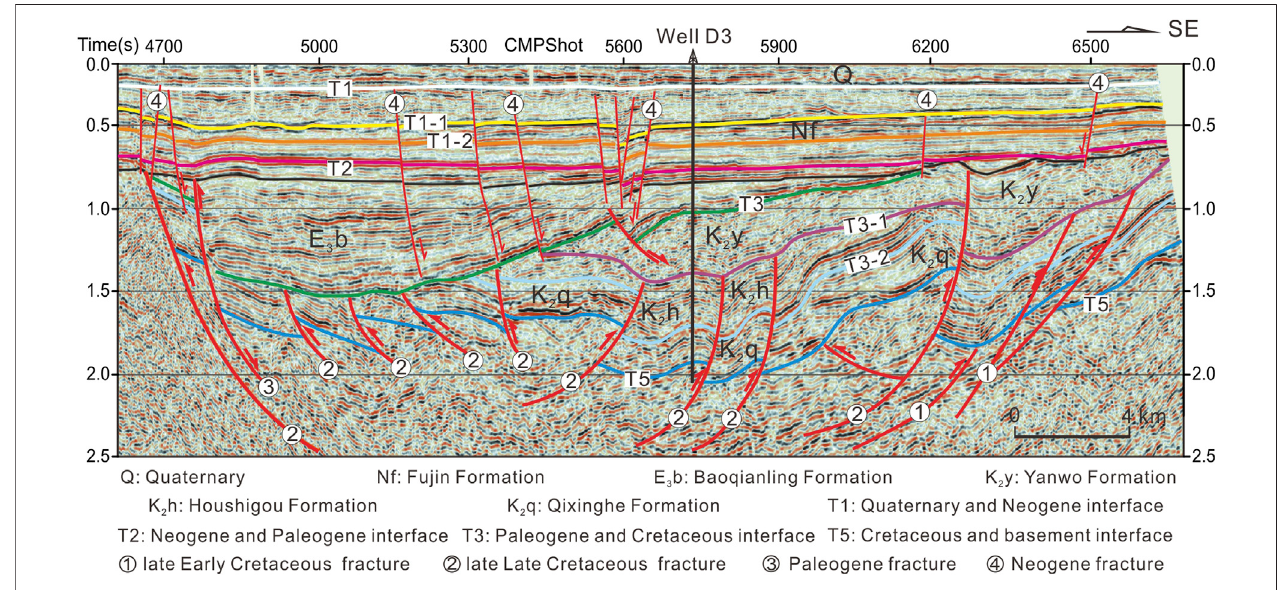
FIGURE4| Seismicre fl ectioncharacteristicsofcompressionalfaultsfromlateLateCretaceoustoearlyPaleogene(QianjindepressionofSanjiangbasin).Datafrom the project research team, and the strata calibration of the well (modi fi ed after Zhang F.-Q. et al., 2015).